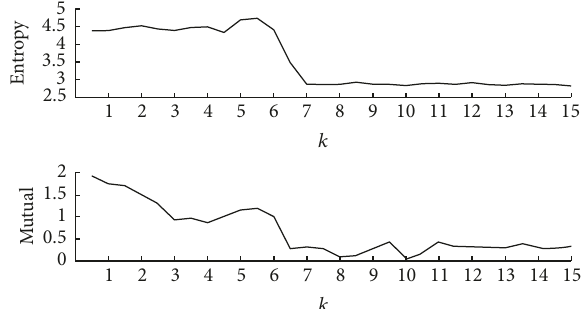
Figure 5: Evolution of entropy and mutual information (mutual) of the model as a function of the global coupling strength (𝑘)